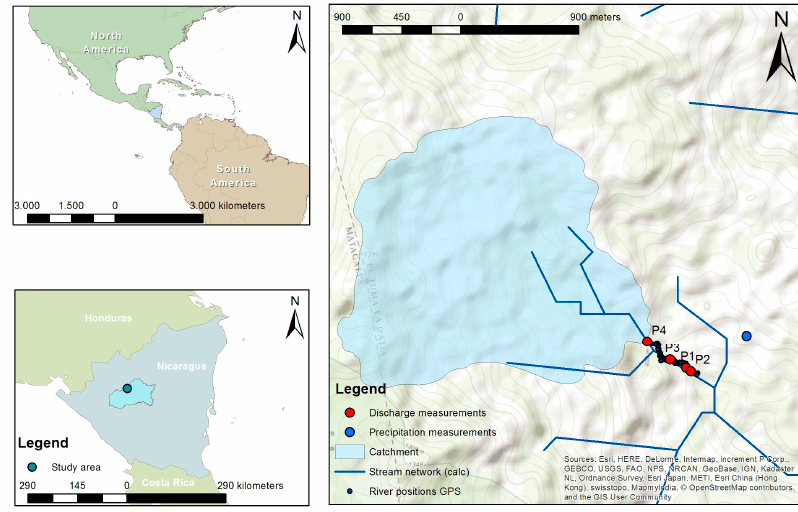
Figure 1. Study area location.